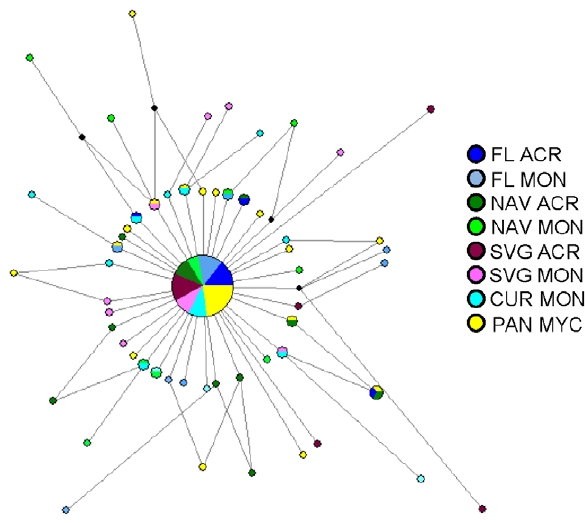
Figure 2. Median joining network for cytb haplotypes from a sample of 130 Coralliophilaabbreviata . Circles represent individual haplotypes. The size of the circle is proportional to the frequency of the haplotype in the sample and branch lengths are proportional to the number of mutational steps (range: 1–3). Small black circles represent missing/theoretical haplotypes.